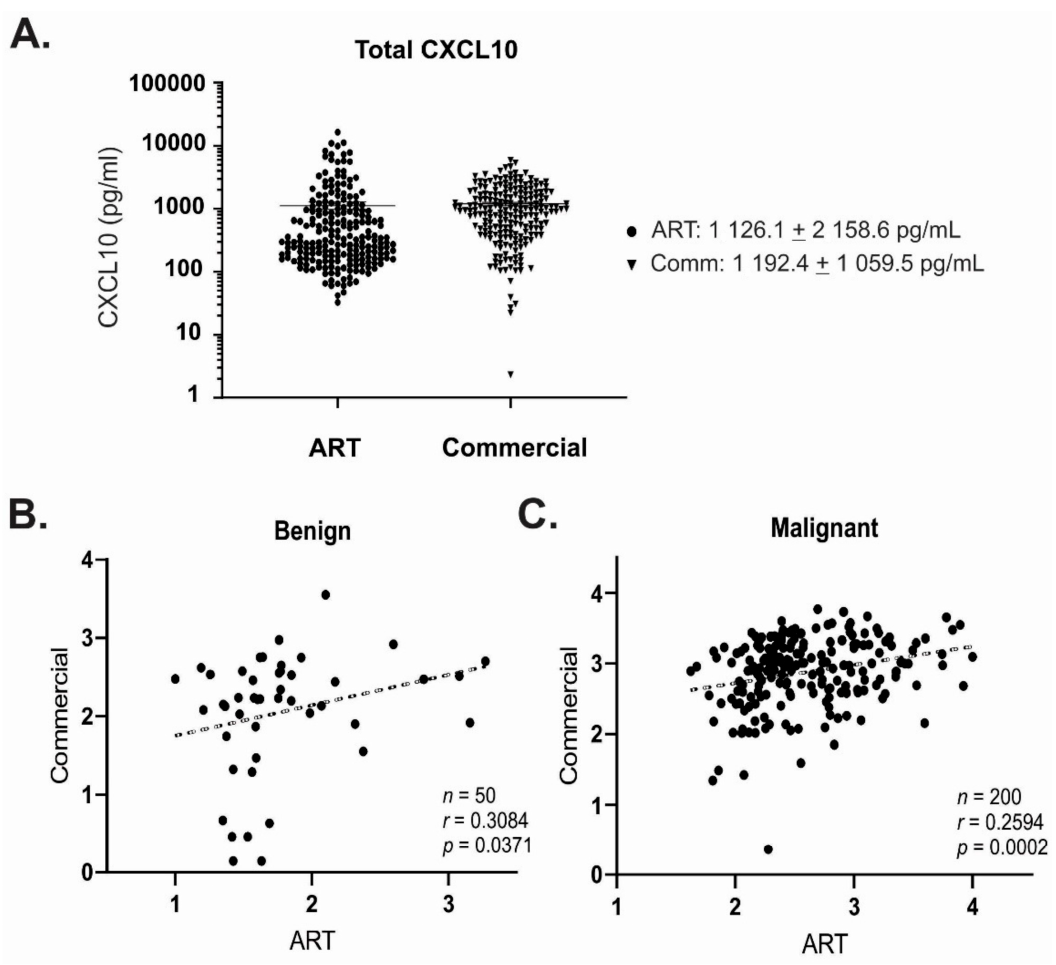
Figure 2. ( A ) Comparison of total CXCL10 detection using ART or commercial ELISA in ascites fluid from ovarian cancer patients ( n = 212). Data is mean +/ − SD, triplicate replicates per sample; ( B , C ) Significant correlations were observed between measurements made using ART or commercial ELISA for both ( B ) benign ( n = 50; p = 0.0371); and ( C ) malignant ( n = 200; p = 0.0002) sample